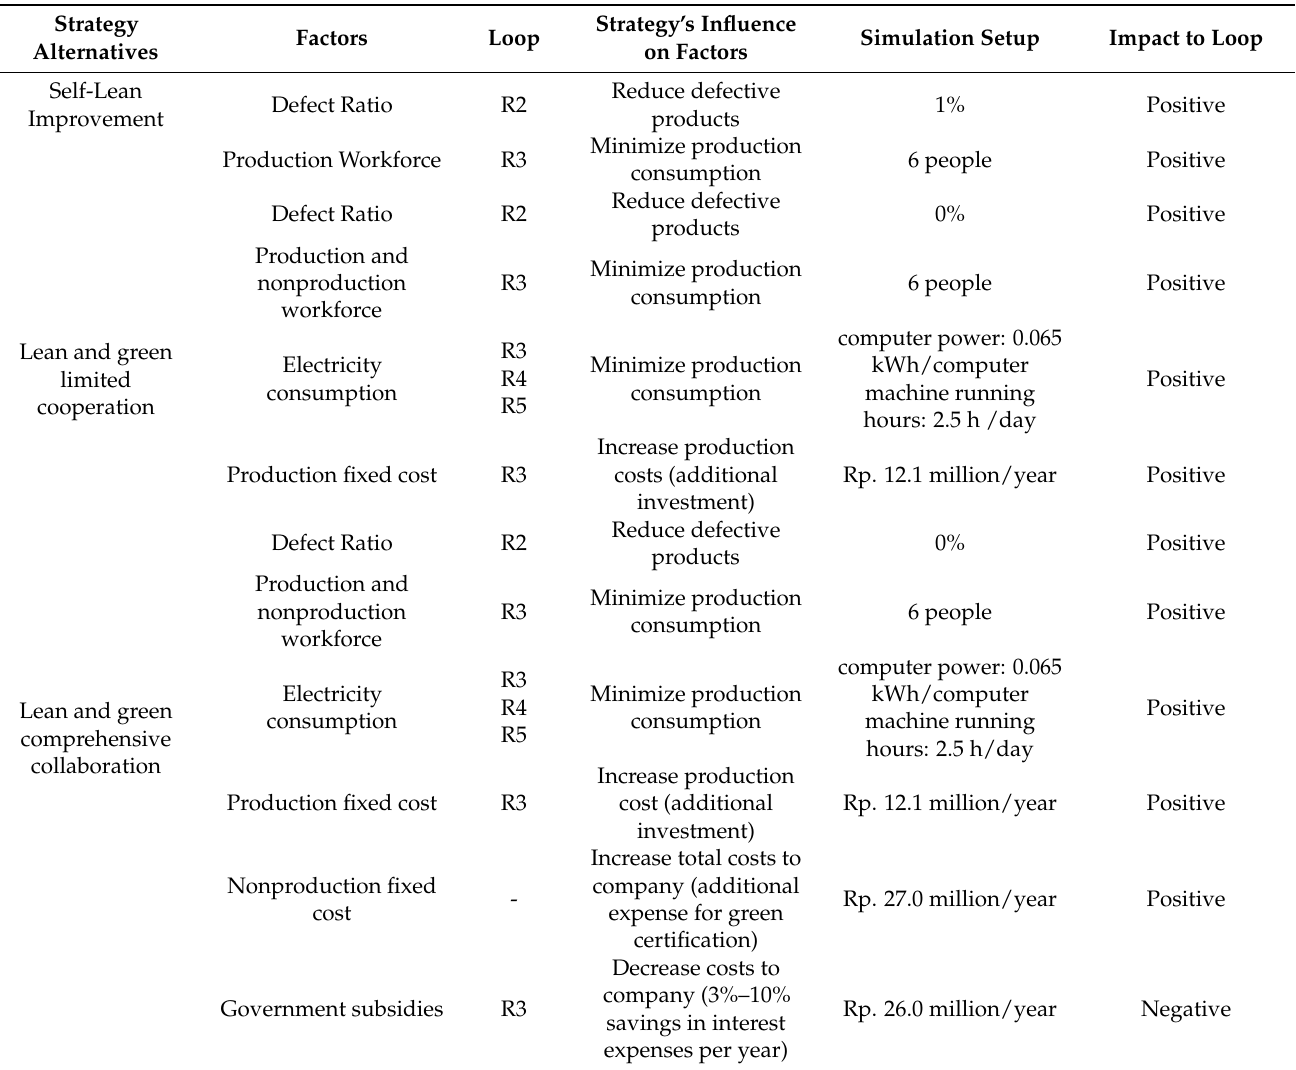
Table 1. Mapping strategy alternatives and policy